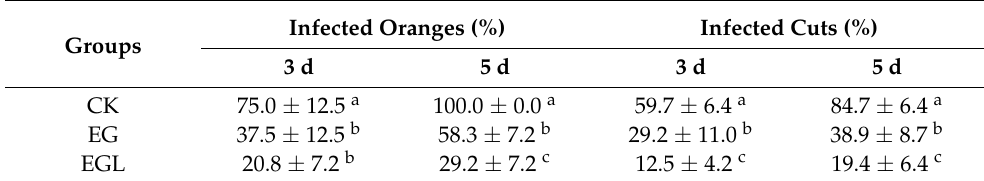
Table 2. Percentages n (%) of the infected oranges and infected cuts inoculated with P.italicum. Infected Oranges (%) Groups